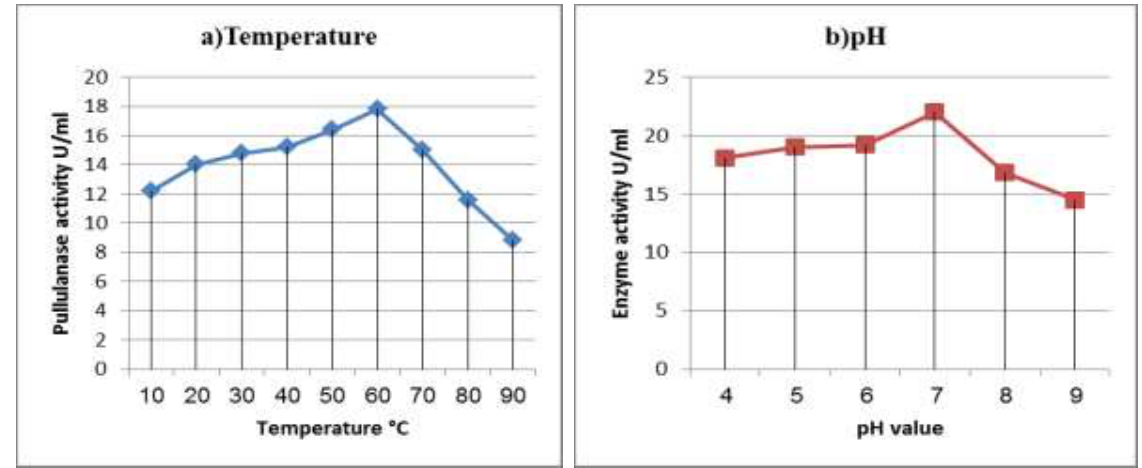
Figure 2 : Effects of a) Temperature and b) acidity on pullulanase activity.